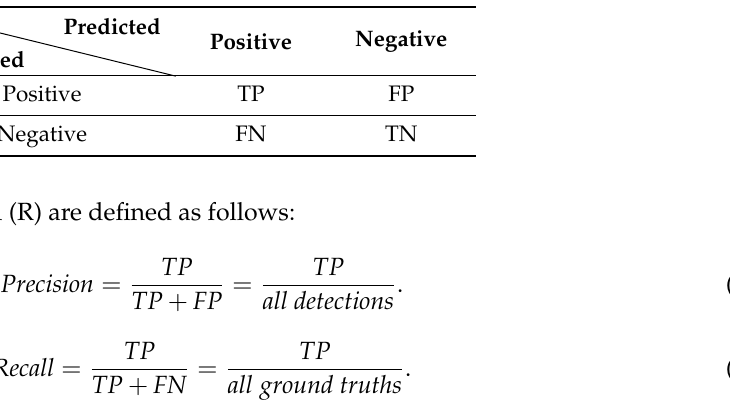
Table 4. Confusion matrix of the classification results. TP—true positive; FP—false positive; TN—true negative; FN—false